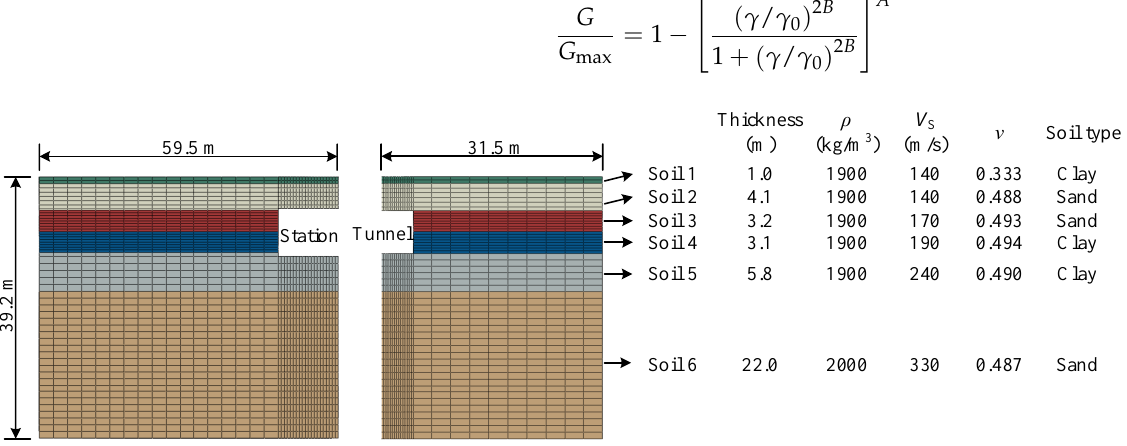
Figure 9. Cross-section of finite element model of soil.